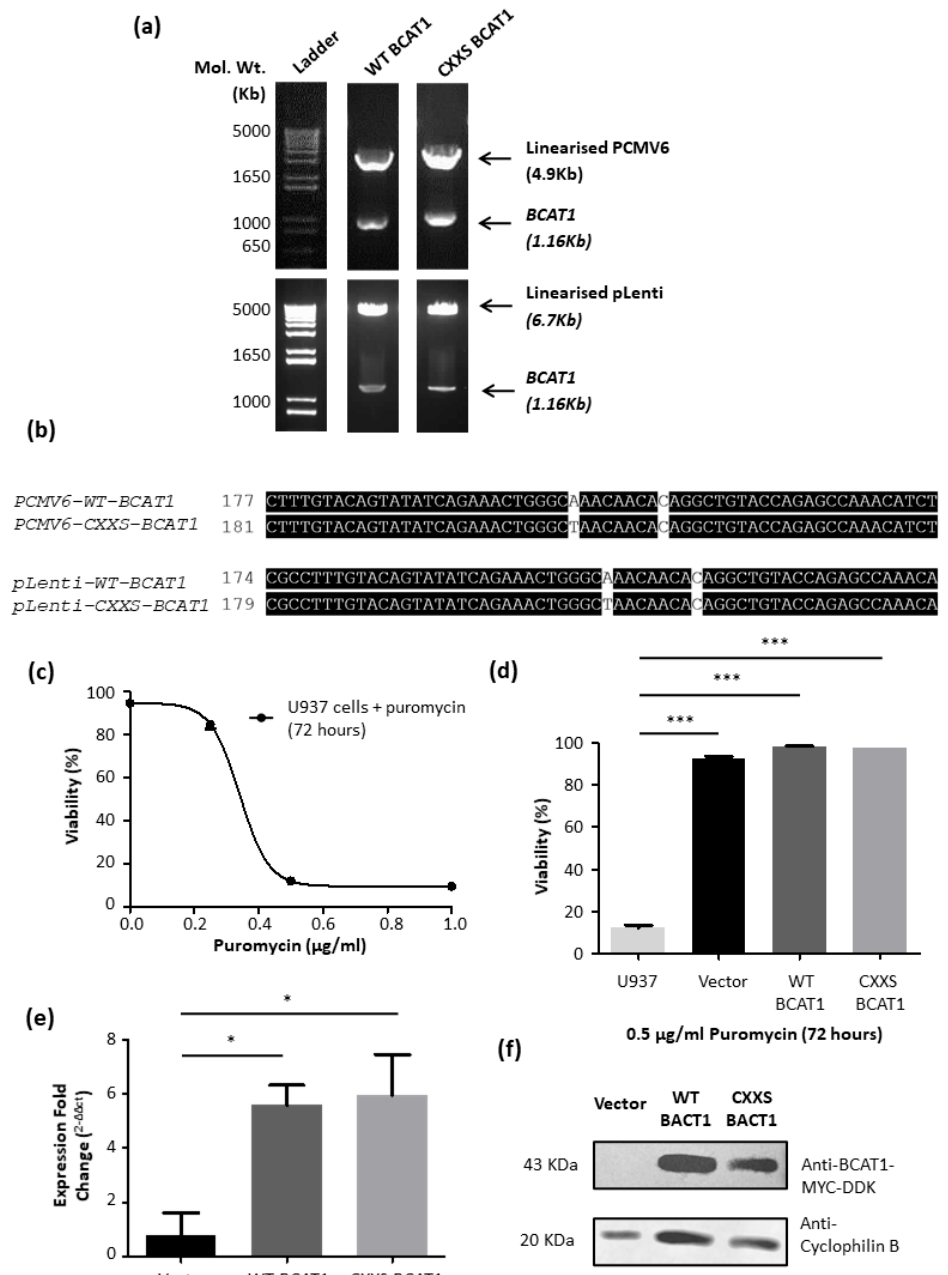
Figure 3. Subcloning BCAT1 cDNA to pLenti vector and overexpression of BCAT1 in U937 cells. ( a ) Agarose gel image displaying subcloning of WT BCAT1 and CXXS BCAT1 cDNA from pCMV6- Entry to pLenti vector. Successful insertion of BCAT1 was confirmed by the presence of a 1.16 Kb band. ( b ) Sequence alignment of pCMV6- BCAT1 and pLenti- BCAT1 using M-Coffee (OmicX, Le Petit-Quevilly, France), CXXC → CXXS base substitutions are highlighted in white, as confirmed by capillary sequencing. ( c ) 72 h dose-response curve to determine the minimum inhibitory concentration of puromycin for U937 cells. ( d ) Graph displaying cell viability and selection of pLenti vector transformed U937 cells following 0.5 µg/mL puromycin treatment and 72 h incubation. ( e ) Graph displaying fold change in BCAT1 expression in transgenic U937 cells compared to U937 control cells. ( f ) Western Blot analysis showing BCAT1 protein expression in transgenic U397 whole cell lysate compared to Cyclophilin B housekeeping control gene and Vector control cells. Data presented are mean ± SD. Significant differences were calculated using 1-way ANOVA with Tukey’s post-test. * p < 0.05, *** p < 0.001 ( n = 4).